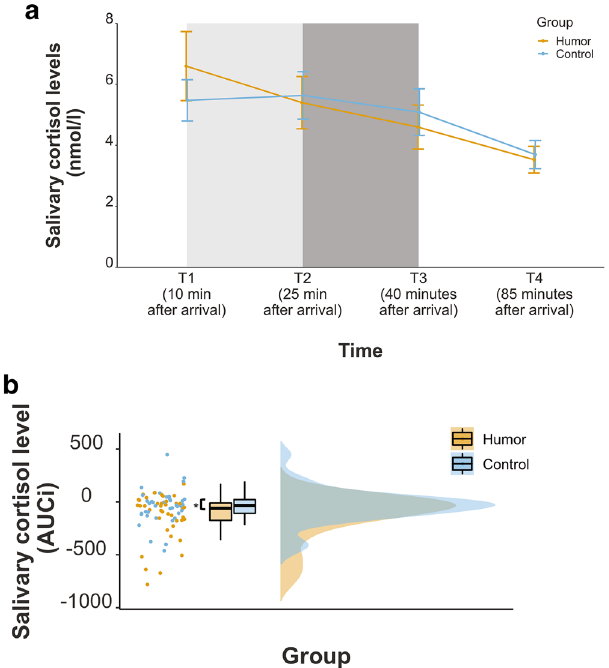
Figure 2. (a) Salivary cortisol levels over the course of the experiment as a function of group. Depicted are raw nmol/l cortisol values for all four measurement timepoints. The light grey shaded area indicates the humor induction phase, the dark grey shaded area indicates the pain tolerance assessment and the stress induction phase. Error bars denote the standard error of the (group) mean. (b) Change of physiological stress levels over the course of the experiment as a function of group. To assess the change in physiological stress levels, the area under the curve with respect to increase was calculated including all four measurements of cortisol levels over the course of the experiment. Asterisks (*) indicate statistically significant differences: * p < .05.